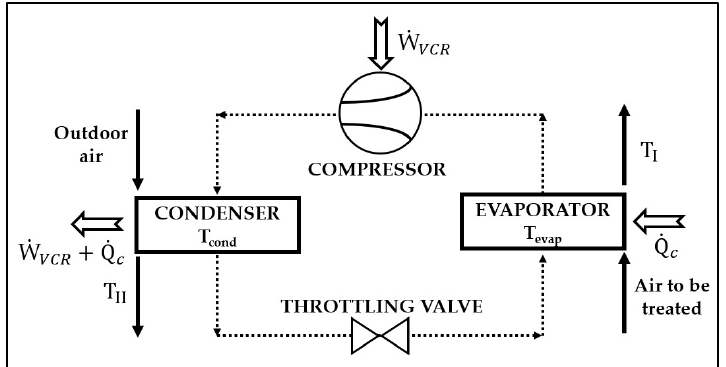
Figure 6. Reference scheme for the VCR cycle.